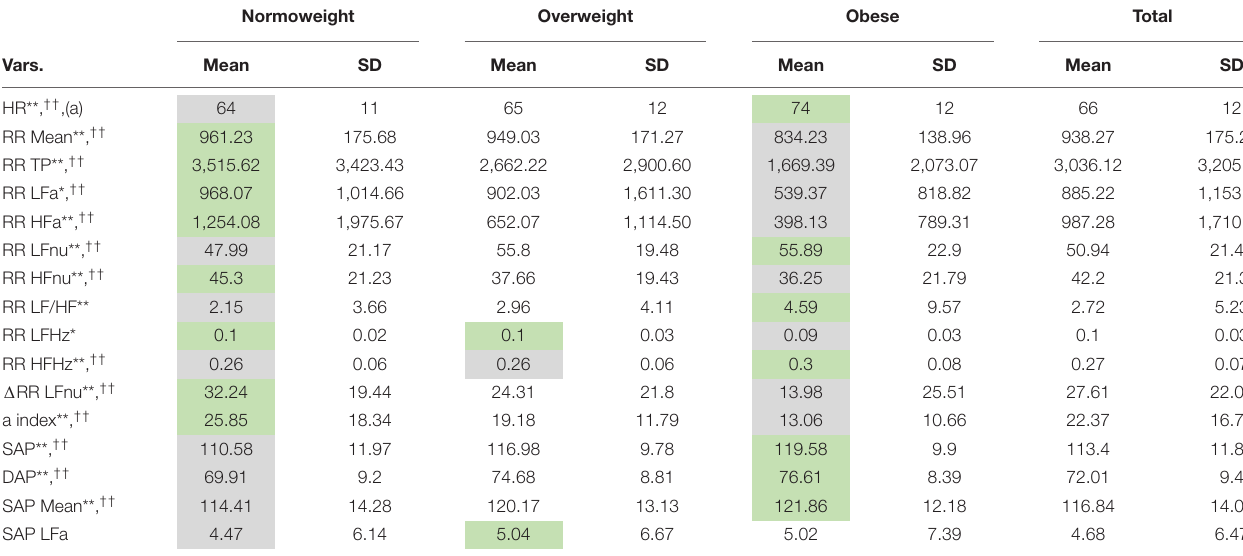
( a ) HR means and standard deviations are rounded to integers. In every comparison among the within-BMI-groups means of each variable, a green cell denotes the largest computed mean, while a gray cell denotes the smallest computed mean. Univariate parametric ANOVA (based on the F test) and Kruskal–Wallis test are alternative inferential procedure used to verify, for each ANS proxy, the null hypothesis of equality of BMI-groups effects: H 0 : τ NW = τ OW = τ OB against the alternative hypothesis: H 1 : τ g (cid:54)= τ g (cid:48) for at least one pair of groups (g , g (cid:48) ), with g (cid:54)= g (cid:48) = normoweight (NW), overweight (OW), obese (OB), and where τ g is the effect of group g. Empirical significance level code in the univariate parametric ANOVA: ** = P ≤ 0.001, * = 0.01 < P ≤ 0.05. Empirical significance level code in the Kruskal–Wallis test: †† = P ≤